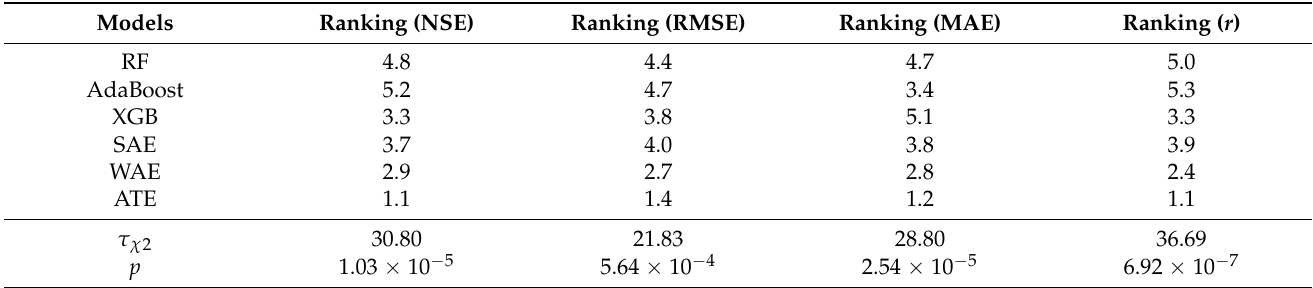
Table 4. The average ranking of each model in each fold for NSE, RMSE, MAE, and r .